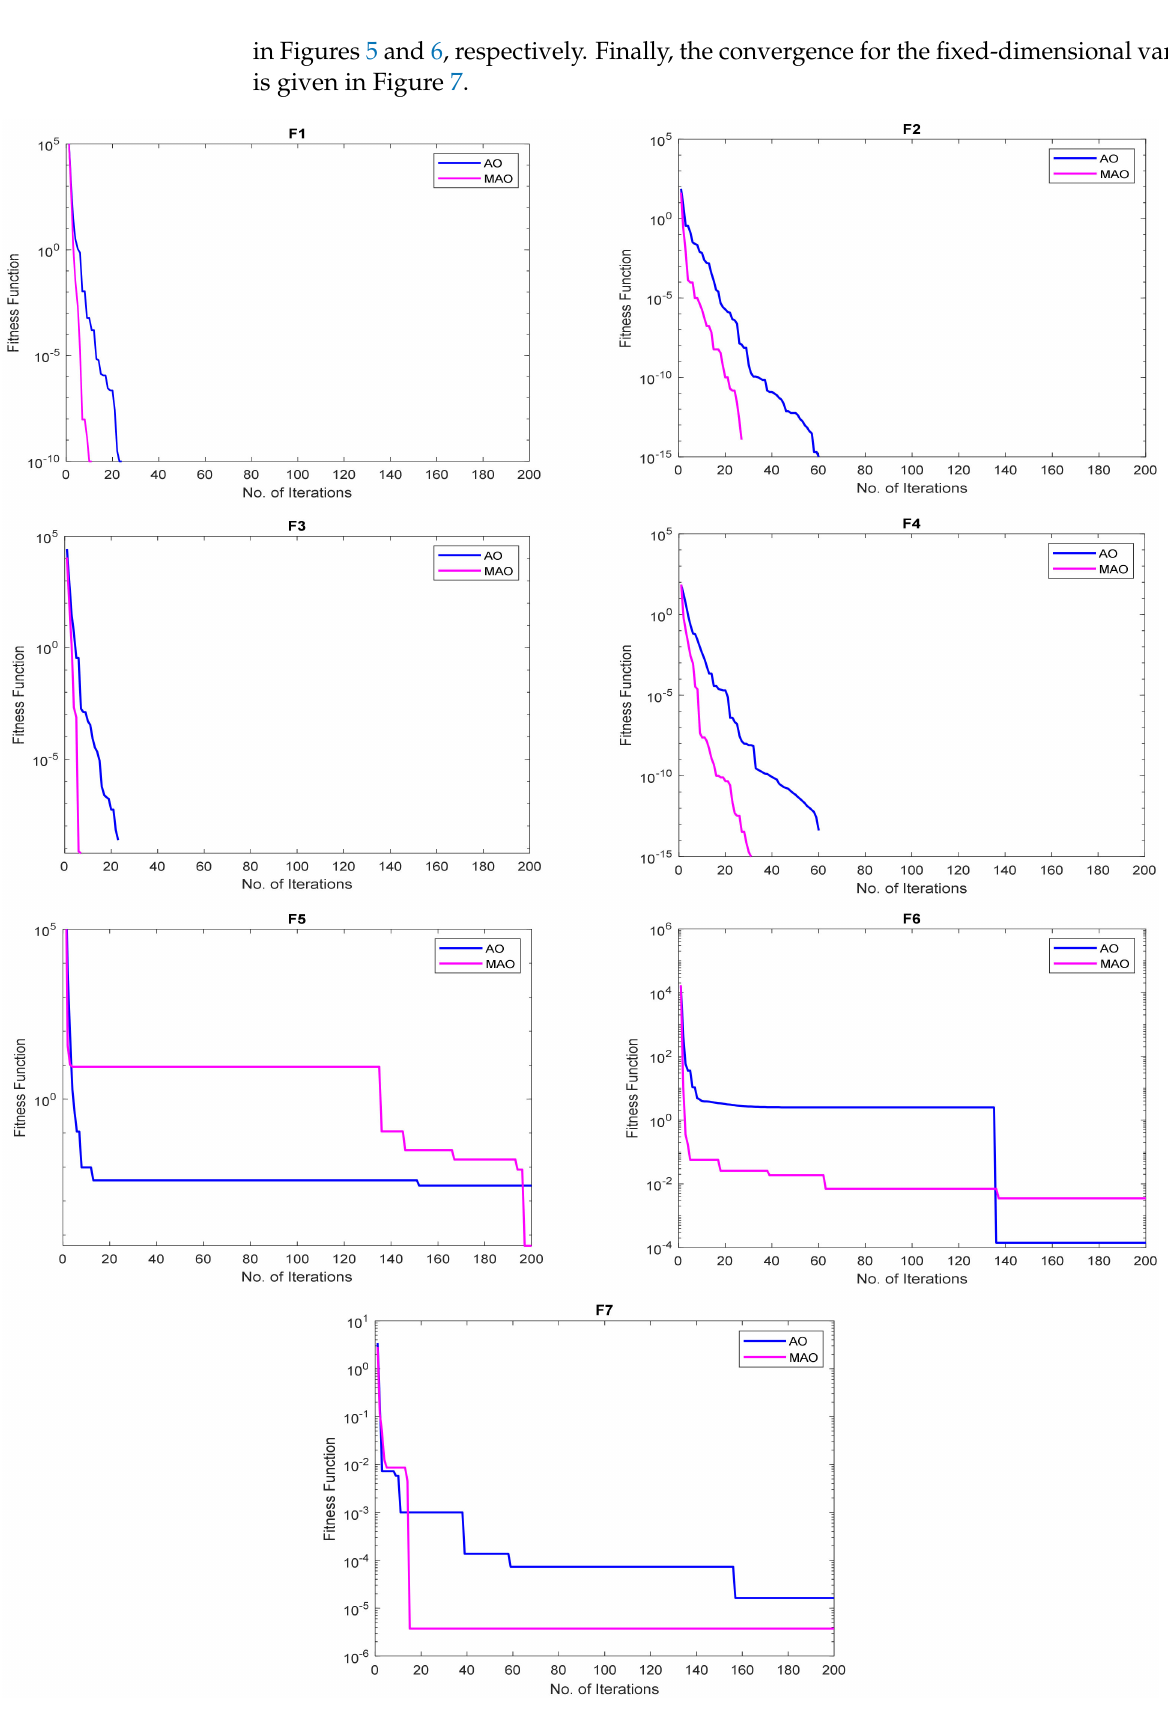
Figure 3. Convergence analysis of unimodal benchmark functions with D =